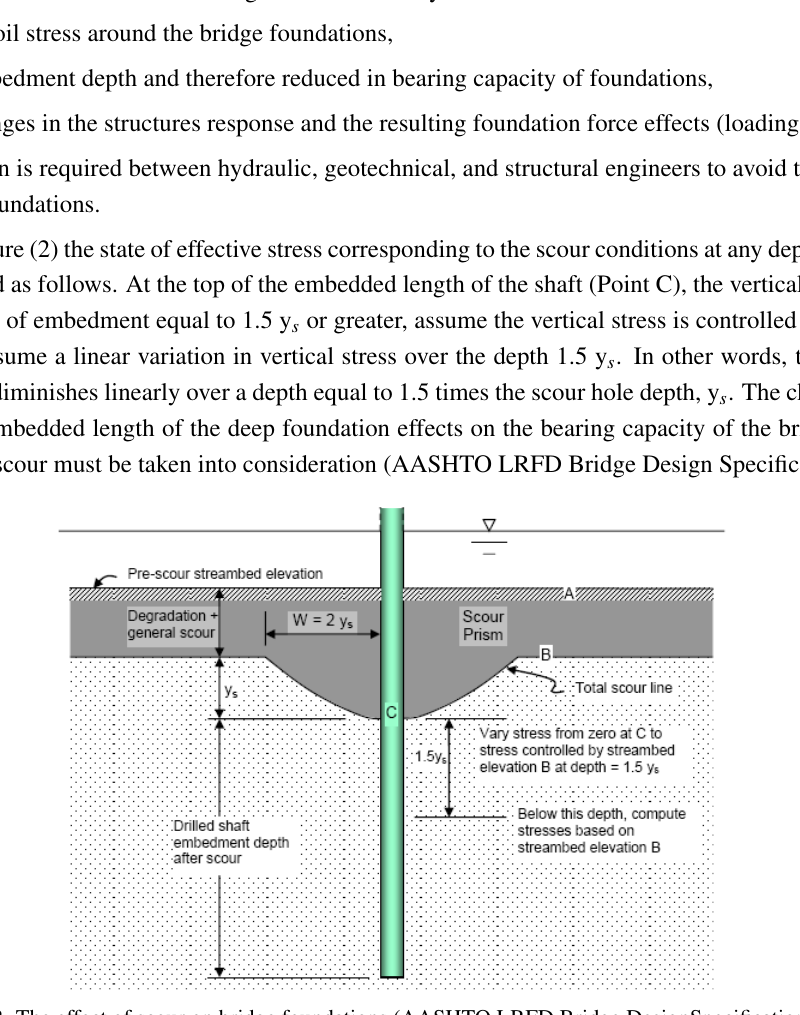
Figure 2. The effect of scour on bridge foundations (AASHTO LRFD Bridge DesignSpecifications,